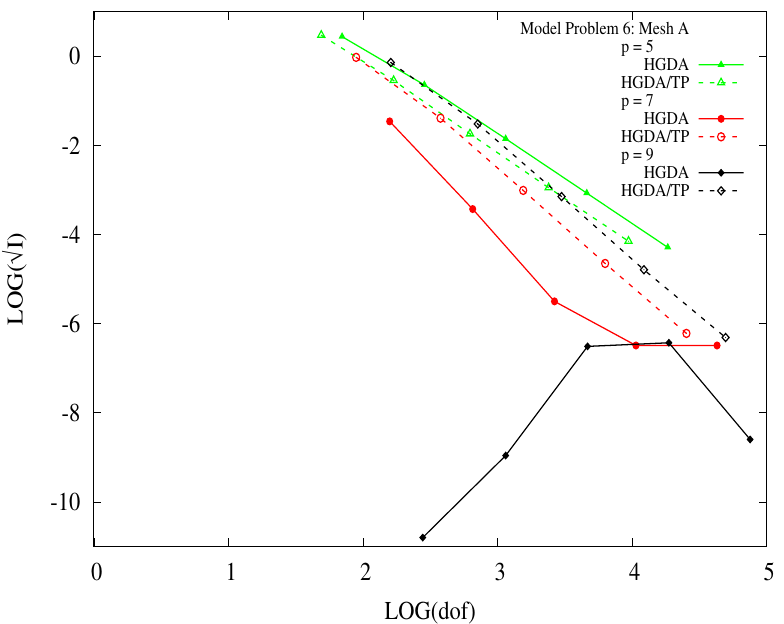
Figure 29. Residual function I versus dof, C 22 solutions: Model Problem 6 (Burgers Equation; Mesh A; HGDA/DG and HGDA/TP).